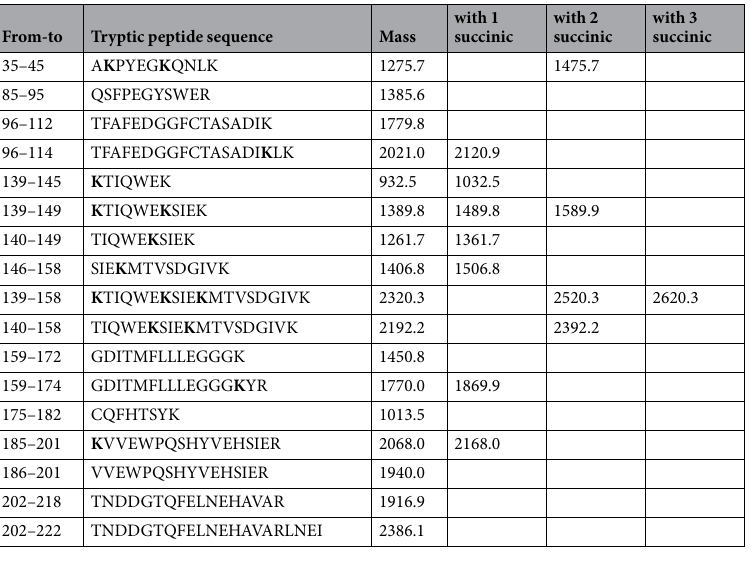
4 SCIeNtIfIC RepoRtS | (2018) 8:15542 | DOI:10.1038/s41598-018-33250-z